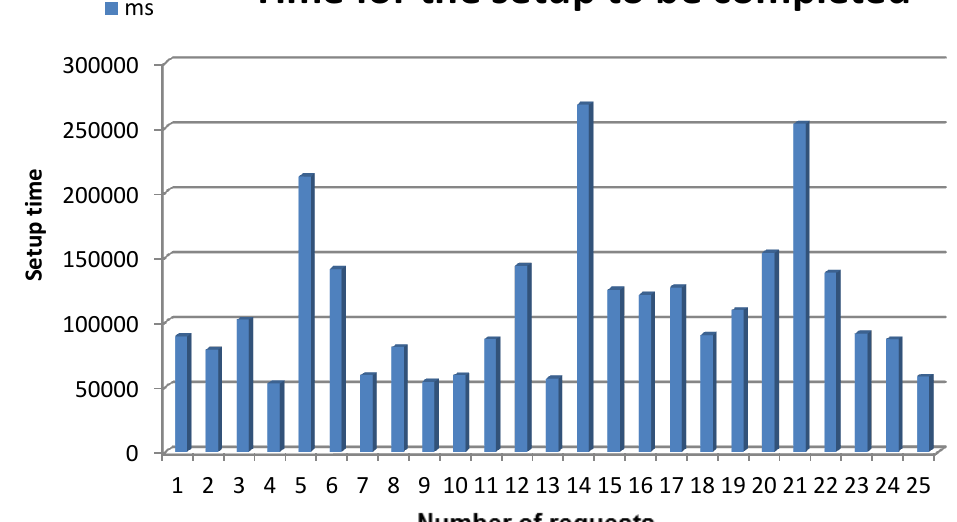
Figure 21. Time used in setting up the WSN (25